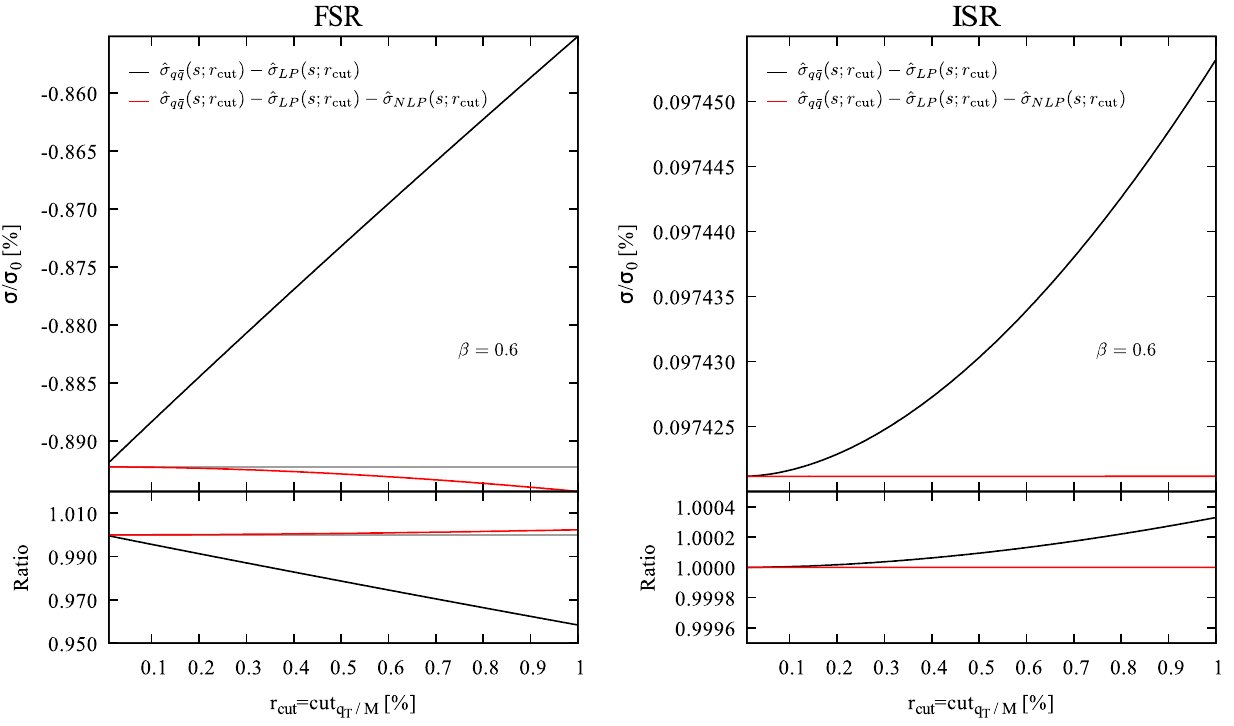
Fig. 4 Subtracted partonic cross section for final-state radiation (left panel) and initial-state radiation (right panel). The solid lines represent the subtraction of the leading-power term, while the red solid line is obtainedbysubtractingalsothenext-to-leadingpowertermsinEqs.(28)